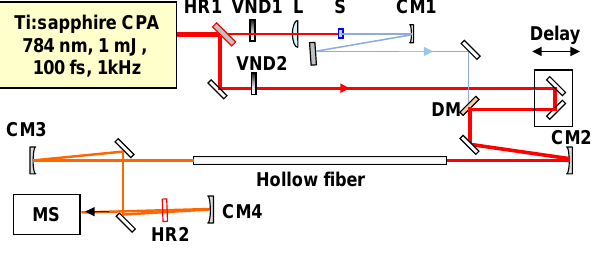
Figure 2. The experimental setup. HR 1,2, high reflector at the pump wavelength; VND 1,2, variable neutral-density filter; L, plano-convex lens ( f = 60 mm); S, sapphire plate; CM 1–4, concave mirrors, f = 100 mm (CM 1), 500 mm (CM 2,3), 200 mm (CM 4); DM, dichroic mirror; MS, multi-channel